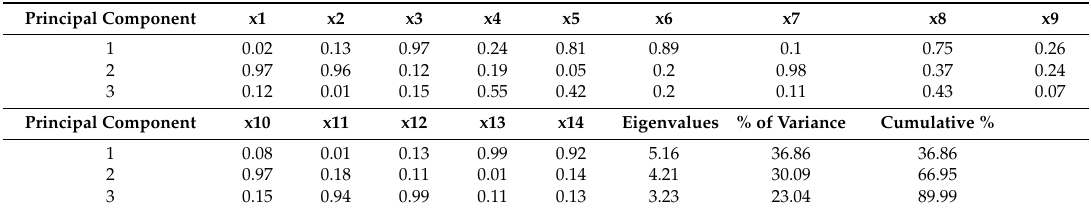
Table 12. PCA of scenario 02 by SPSS 22.0.